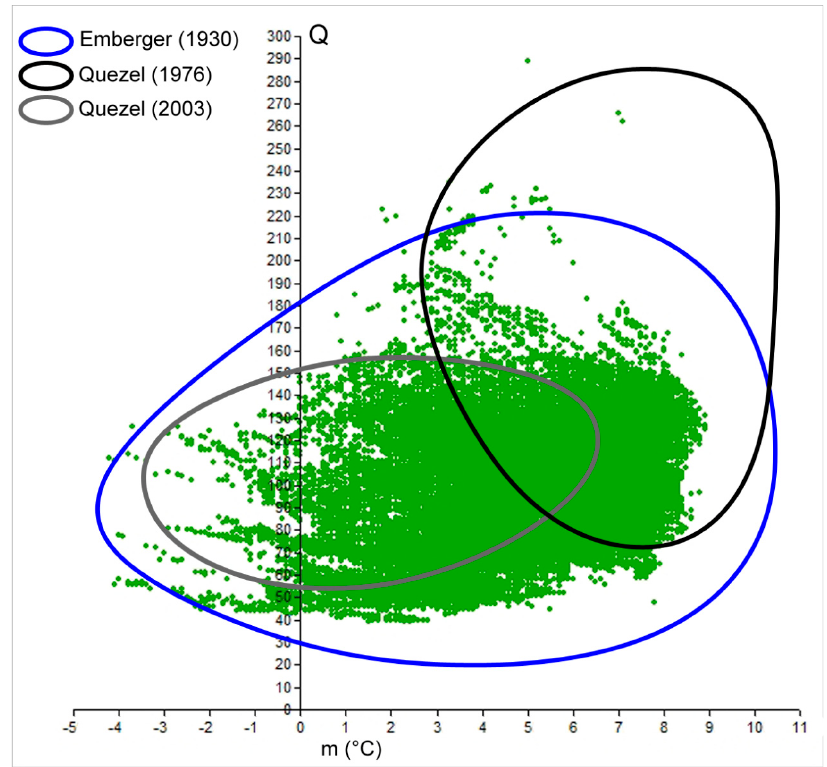
Figure 2. Comparison of cork oak climatograms as reported by Emberger [14] and Quézel [26,30] with the cloud of points of the real distribution at present time (green dots).